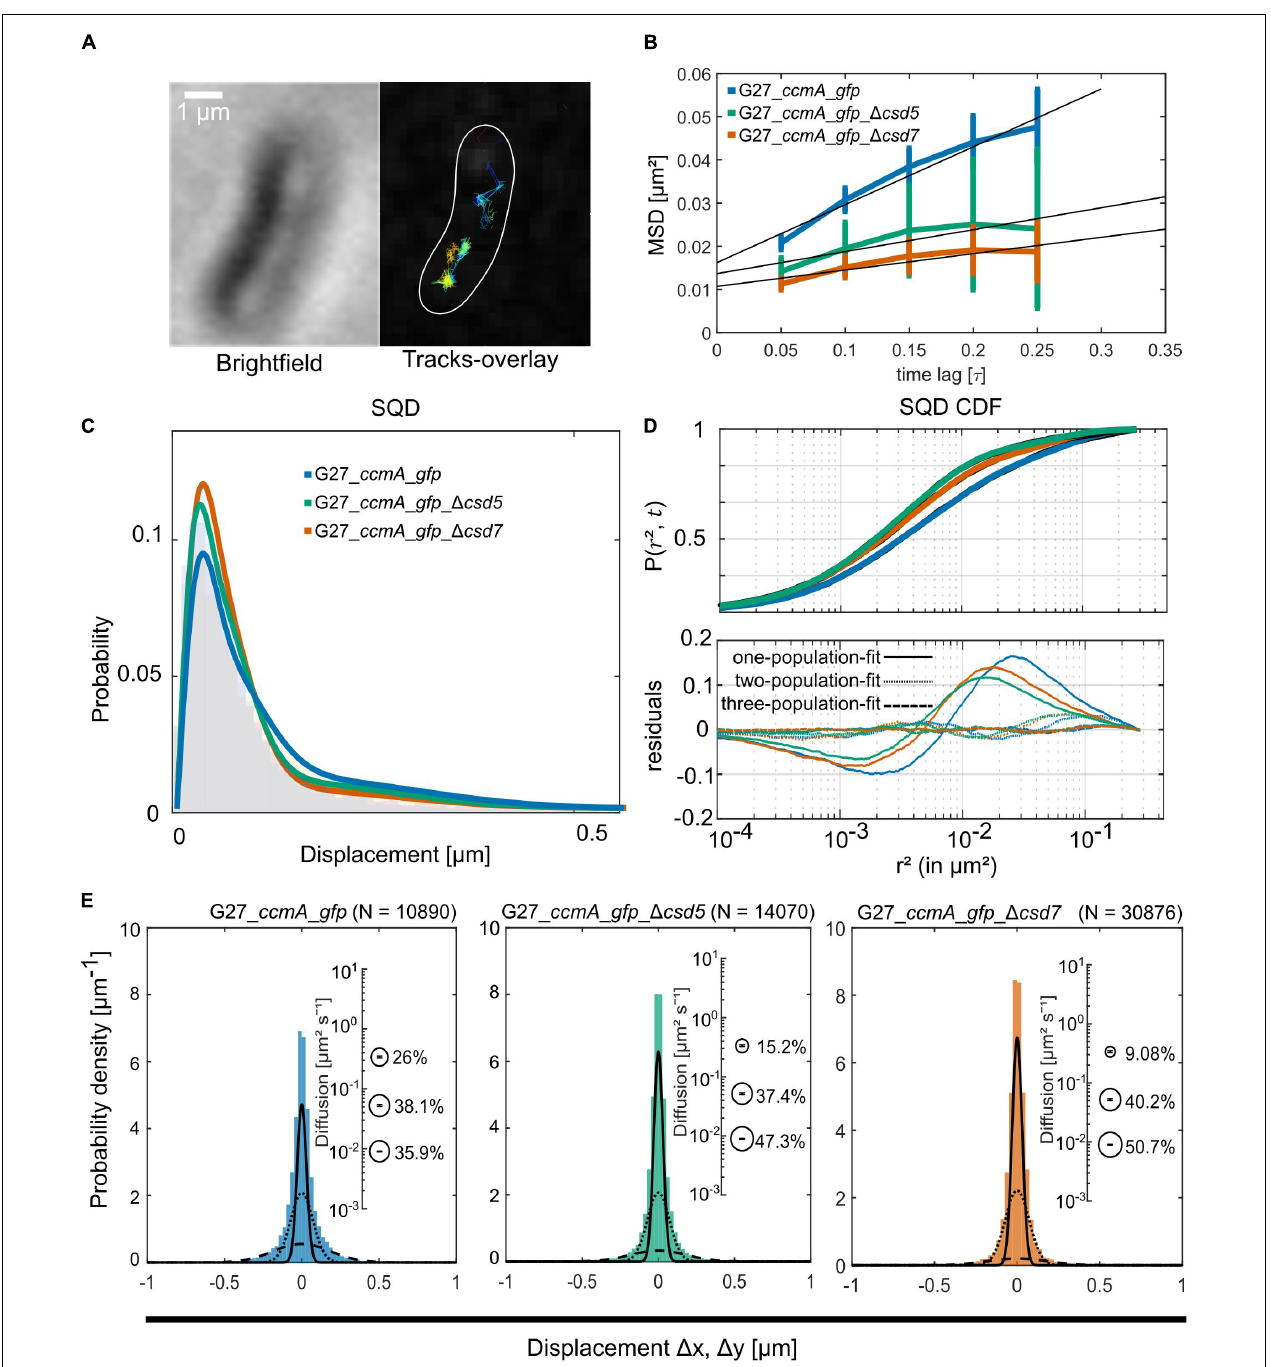
FIGURE 3 | Single-molecule dynamics of CcmA_Gfp in wt, (cid:49) csd5, and (cid:49) csd7 background. (A) Brightfield image of an example cell and respective CcmA_Gfp tracks. Scale bar = 1 µ m. (B) Mean-squared displacement of single-molecule tracks of CcmA_Gfp in different strain backgrounds, plotted against the time lag. (C) Density plot illustrating the probability for different squared displacement lengths for CcmA_Gfp. (D) The cumulative distribution function of CcmA_Gfp squared displacements. The probability for a molecule to stay within a certain radius r 2 at a certain time t is plotted against the radius. The residue plot in the lower panel illustrates the differences of the applied models (single, double, or triple fit) to the data. (E) Probability densities of single-molecule displacements fitted by Gaussian-mixture models. Population sizes estimated from a triple-fit model are illustrated as bubble plots. We observed a slight decrease of CcmA_Gfp single-step distances in the deletion strains as compared to wt